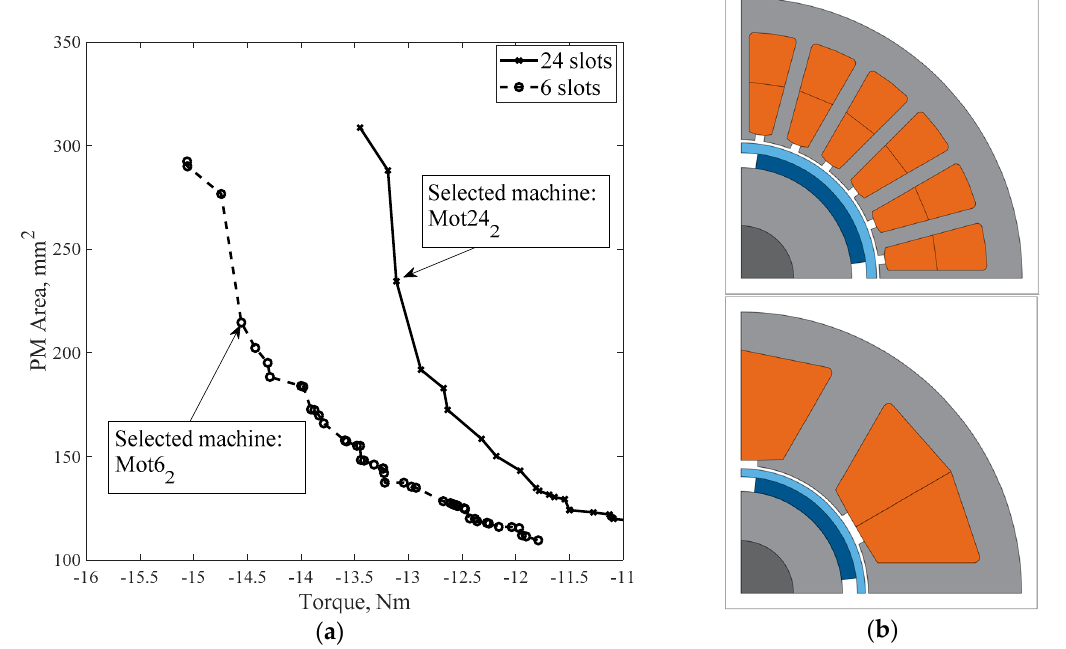
Figure 6. Pareto front of the T/PM run ( a ) and selected 6-and 24-slot machines ( b ).